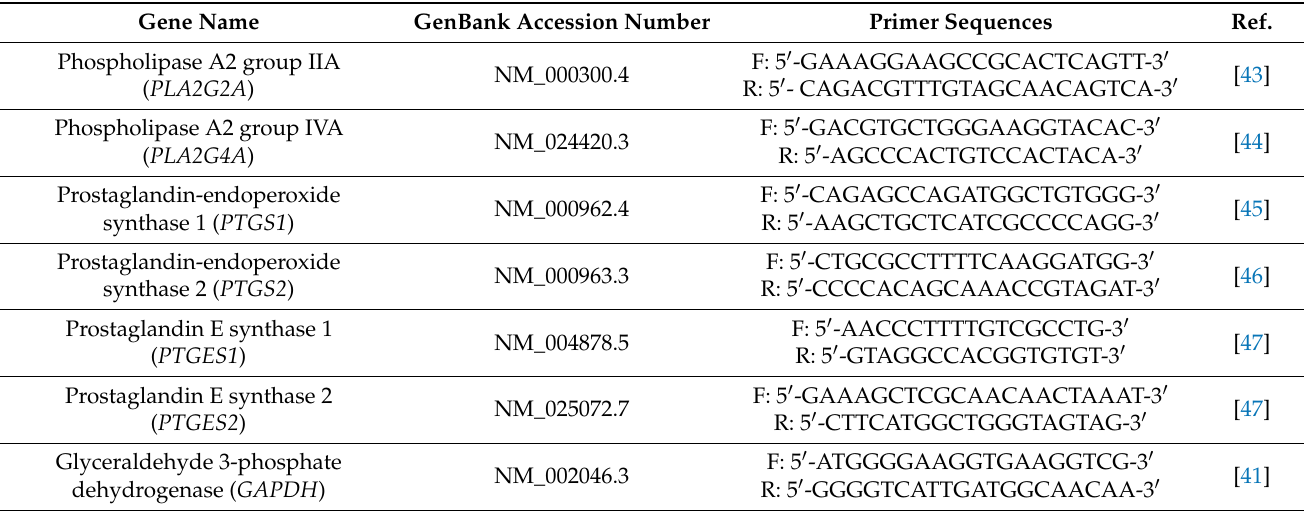
Table 1. Forward (F) and reverse (R) primers for the quantitative reverse transcriptase-polymerase chain reaction